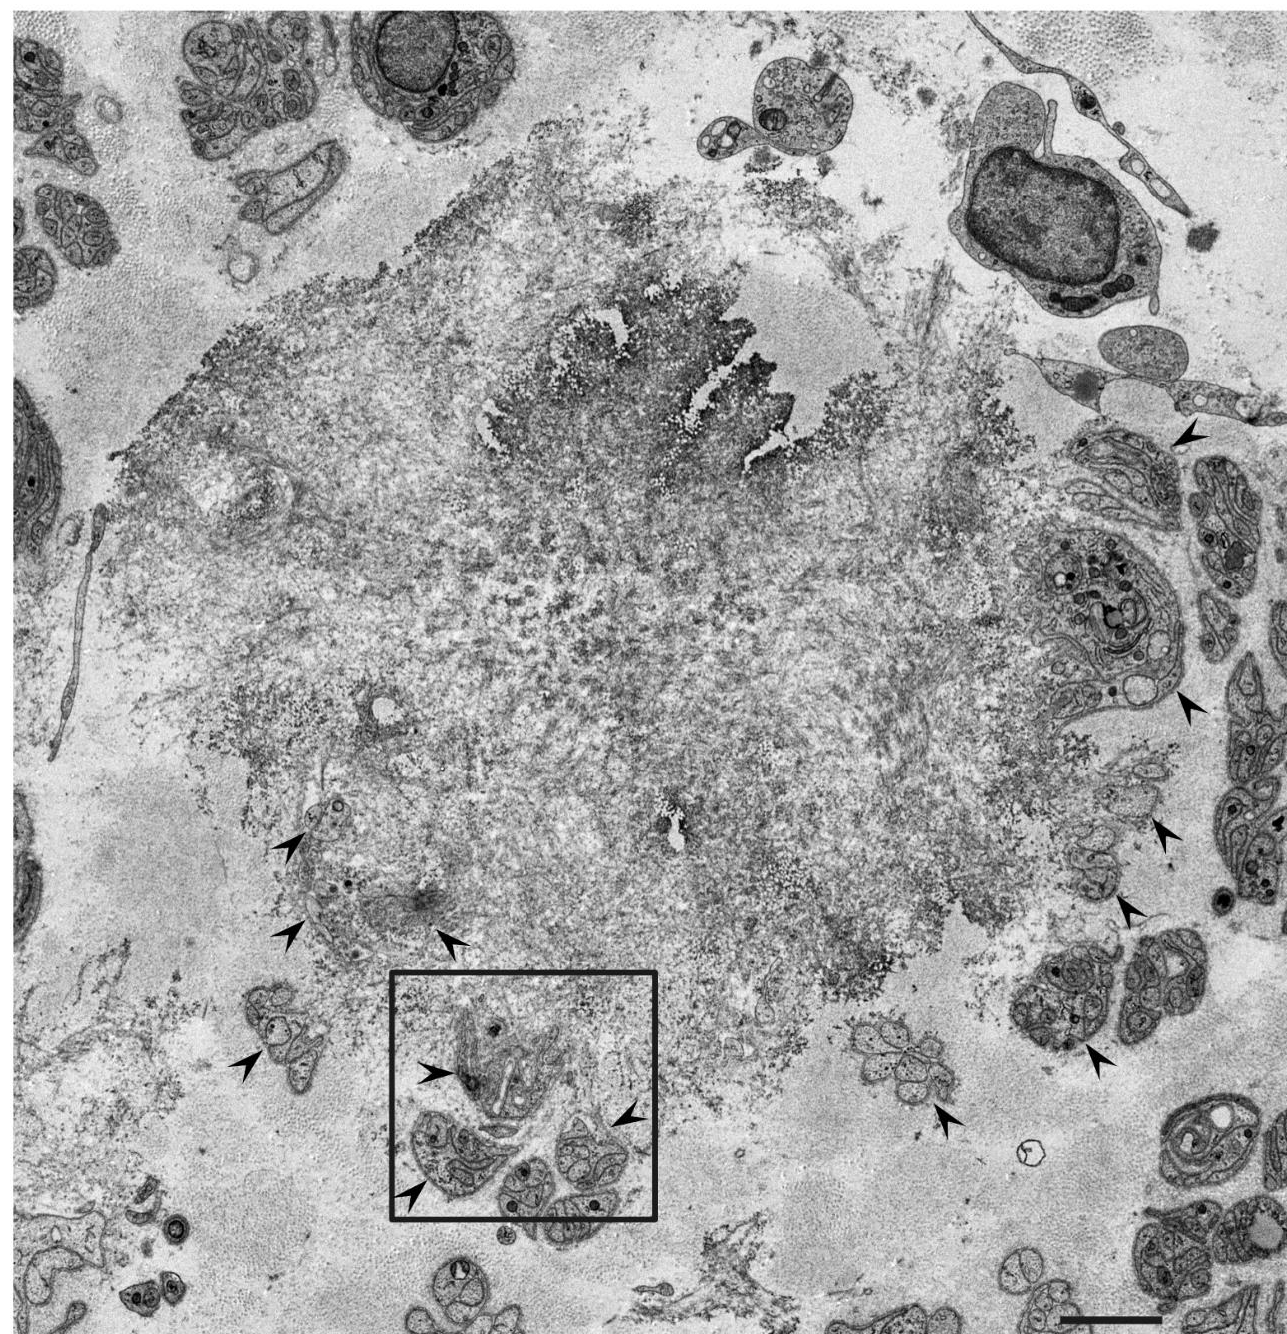
Figure 1. Representative electron microscopy photograph of Schwann cells near a mass of amyloid fibrils. A cross-section of the sural nerve biopsy specimen from a patient with ATTRv amyloidosis. Subunits of Schwann cells indicated by arrowheads are located in the periphery of a mass of amyloid fibrils [28]. A high-powered view in the box is shown in Figure 2. Uranyl acetate and lead citrate stain. Scale bar = 2 μ m.